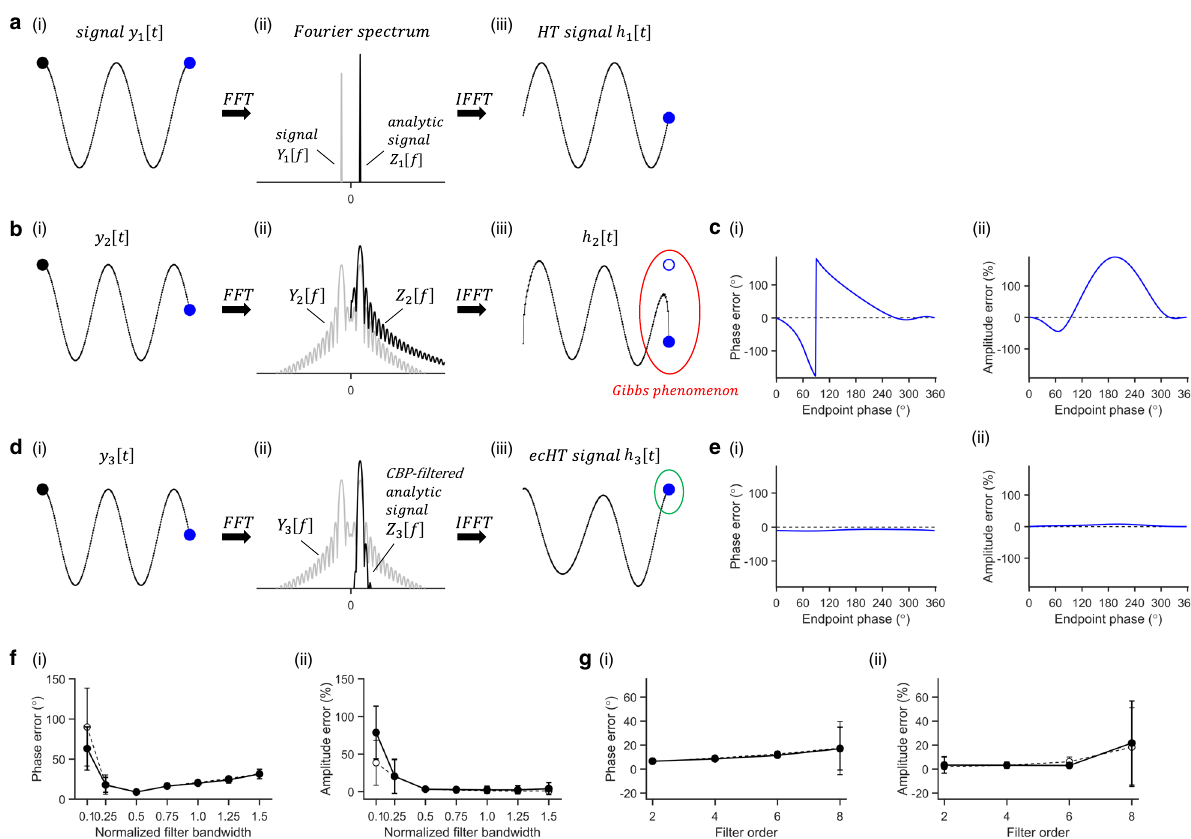
Fig. 1 Concept and simulation of real-time computation of instantaneous phase and amplitude via ecHT. a Hilbert transform (HT) of a fi nite, discrete, oscillatory signal completing full cycles. (i) Test signal y 1 in this example a cosine waveform with normalised amplitude, frequency f 1 = 2 Hz , and phase delay ; ¼ 0 ; sampled at 256 equidistant time-points over 1 s. First and last data points are marked with black and blue circles, respectively. (ii) Fourier spectrum 1 (FS) Y 1 , grey trace, of y 1 , obtained via fast Fourier transform (FFT) of y 1 (in this example using 256 equidistant frequency-points), and FS Z 1 , black trace, of the analytic signal, obtained from Y 1 by deleting the negative frequencies and doubling the amplitude of the positive frequencies; y -axis in log-scale. Y 1 trace at positive frequencies is overlaid by the Z 1 trace. (iii) HT h 1 obtained via inverse FFT of Z 1 ; fi lled blue circle, computed endpoint; non- fi lled blue circle, actual endpoint (in this case, overlaid by the fi lled circle). b HT of a fi nite, discrete, oscillatory signal not completing full cycles. Test signal y 2 similar to y 1 but with f = 2.25 Hz . Showing the same as in ( a ), but with FS sampled using 2048 points to illustrate the formation of the sinc waveform; red ellipse, outlines the 2 Gibb phenomenon at the end of the signal. c Computation error of (i) phase and (ii) amplitude at the signal ’ s endpoint for different end phases, simulated by varying f 2 between 2 Hz and 3 Hz . d Endpoint corrected Hilbert transformation (ecHT) of the same signal in ( b ), i.e. f 3 = f 2 . Showing the same as in ( b ), but with the FS of the analytic signal multiplied by a response function of a causal bandpass (CBP) fi lter, in this example, 2nd order Butterworth bandpass f 3 fi lter with centre frequency f ; green ellipse, outlines the mitigation of the Gibb phenomenon at the end of the signal. e Computation error 3 and bandwidth 2 of (i) phase and (ii) amplitude at the signal ’ s endpoint obtained via ecHT. Showing the same as in ( c ). f Effect of fi lter ’ s bandwidth on ecHT computation error of (i) phase and (ii) amplitude at the endpoint. Shown values are mean ± st.d.; n = 180 phase intervals between 0 and 2 π ; fi lled black markers, error computed as in ( e ) for different fi lter bandwidths normalised to the fi lter centre frequency (in this example f 3 ); non- fi lled markers, error at the same data- point introduced by the fi lter, obtained by simulating a signal with a twice time interval to shift the Gibbs phenomenon from the original endpoint. g Effect of fi lter ’ s order on ecHT computation error at the endpoint. Showing the same as in ( f